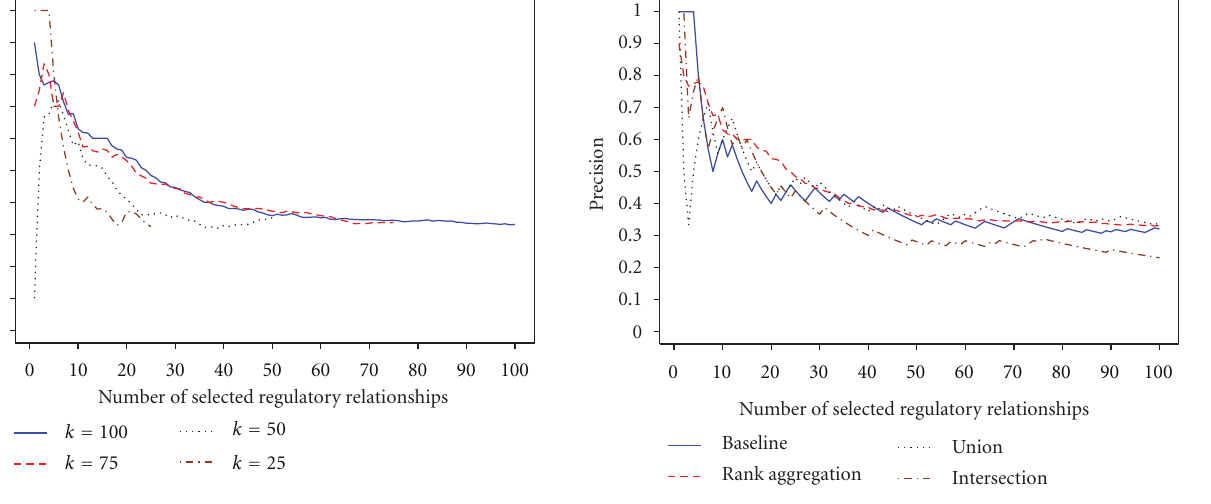
and baseline precisions. For each of the three integration methods, the figure shows the precision (8) when the top i ( i = 1,2, ... ,100) regulator-module interactions in the rank given by the integration method are selected. For a given i , the baseline precision denotes the maximum of precisions obtained by individual learning algorithms